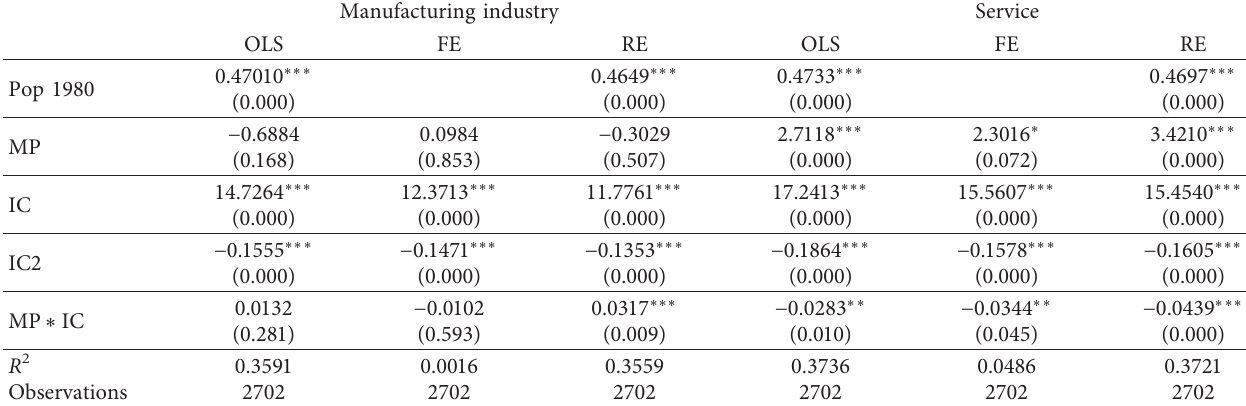
Table 8: Comparison between manufacturing and service shares, 10-year periods. Manufacturing industry